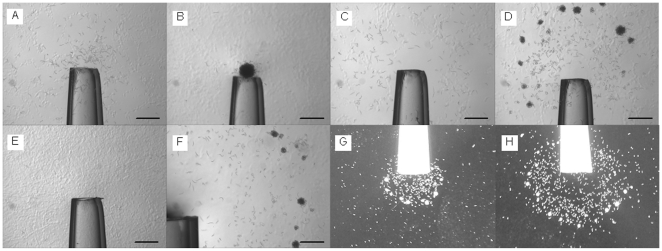
Response of Meloidogyne hapla VW9 to potassium cyanide gradients in PF-127 gel.Region of the gel around the small opening of chemical dispenser with 2 mM KCN is shown at 5 h (A) and 24 h (B) after initiation of the assay. Same region when dispenser contains 5 mM KCN is shown at 5 h (C) and 24 h (D). Panel E shows opening of dispenser containing water at 24 hr. Panel F shows a detail of large end of dispenser with 5 mM KCN at 24 hr. Panels G and H are taken at lower magnification with backlighting. In these panels the large end of the dispenser (4 mm diameter) is shown for 2 mM KCN (G) and 5 mM KCN (H) at 24 h after assay initiation. Petri dish containing 600 J2 per ml PF-127 gel was used for each assay. Scale bar in A-F is 1 mm.